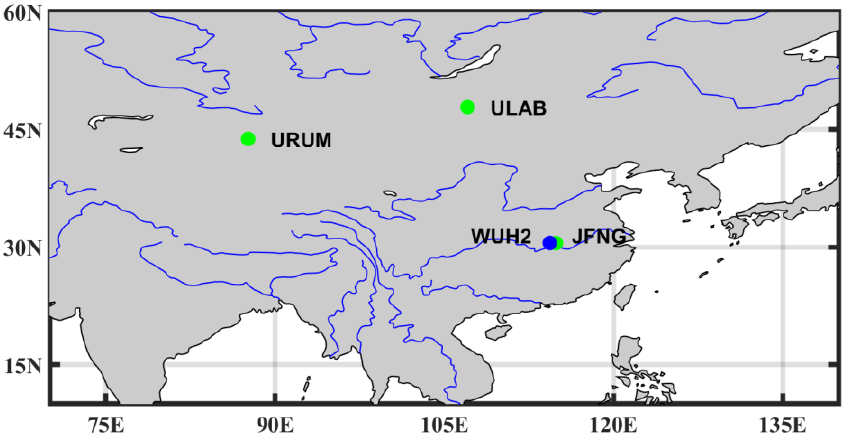
Figure 1. The location of 4 selected MGEX stations.